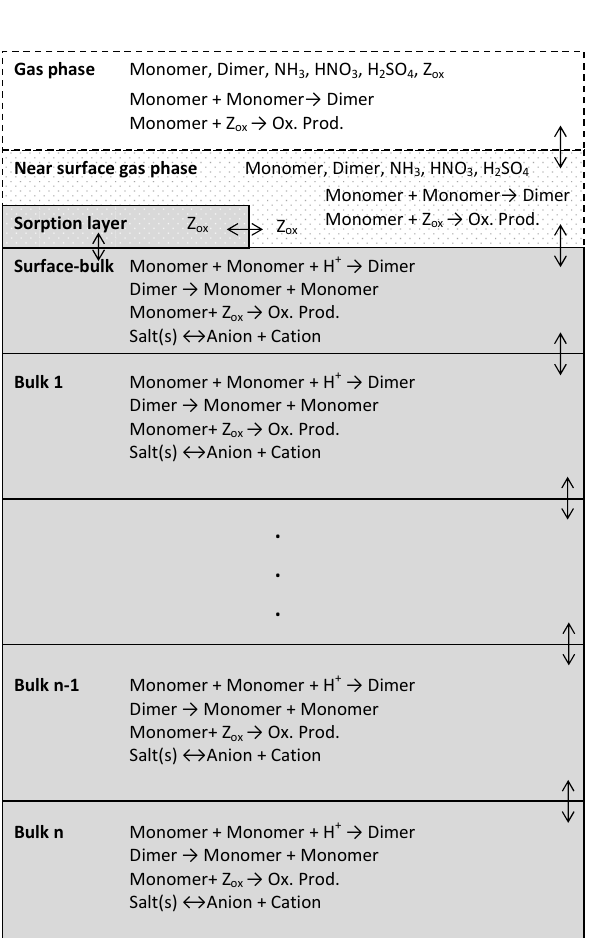
Figure 3. Schematic picture which illustrates the model structure and processes included in the kinetic multilayer model in ADCHAM. The double arrows represent the mass transport between the layers.